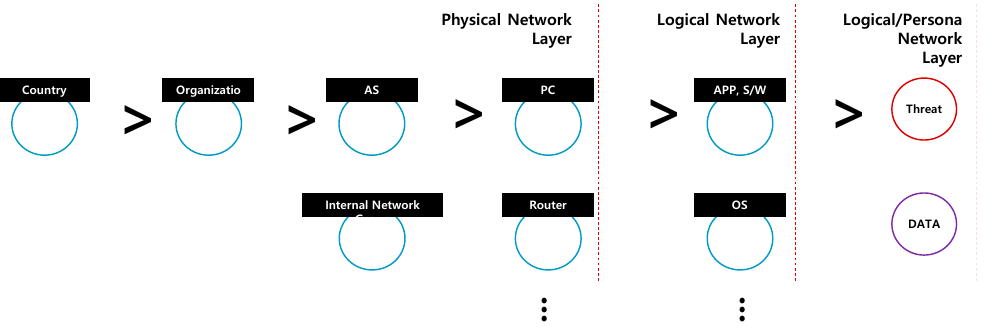
Figure 12. Diagram of Object Relationships between Network Layers.